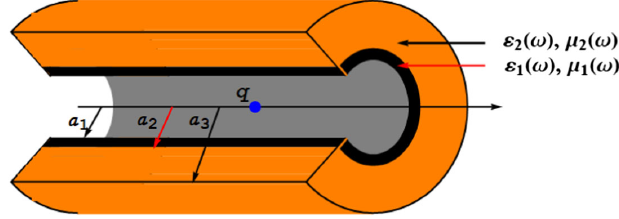
FIG. 1. Round two-layer metal-dielectric